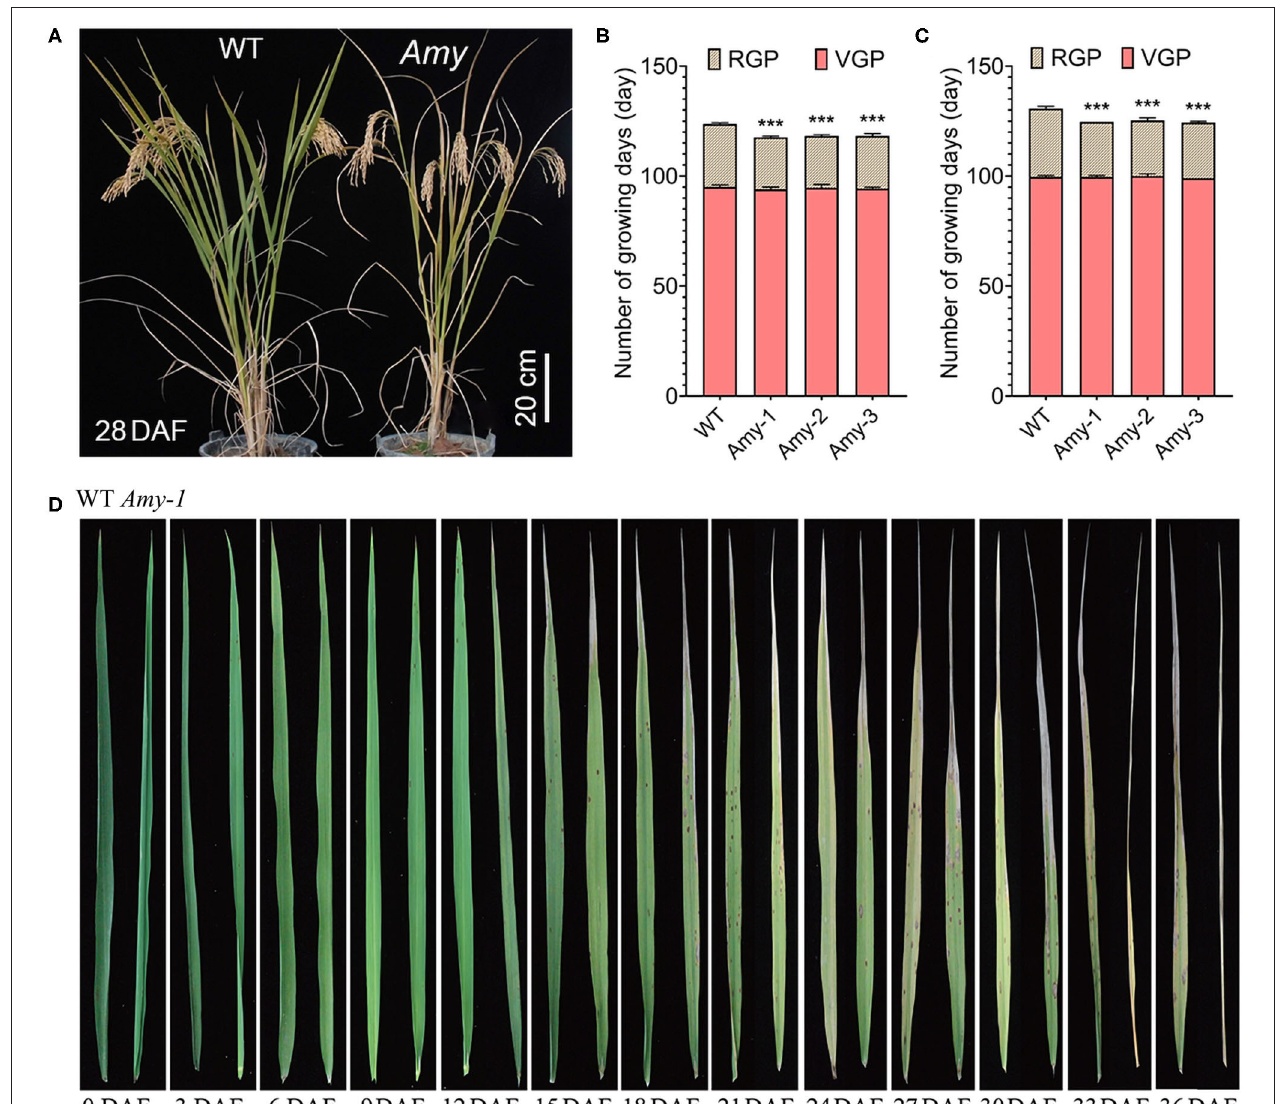
FIGURE 3 | Rice plant morphology at harvest and the change of blade leave after flowering. (A) Rice plant morphology at 28DAF. (B) Number of rice growth days in the summer season at Changsha. (C) Number of rice growth days in the winter season at Sanya. RGP-reproductive growth period, VGP-vegetative growth period. Values are given as the mean ± SD. *** P < 0.001 compared with the wild type using Student’s t -test. (D) Changes in rice leaves after flowering. For each DAF, left for WT leaf and right for Amy-1